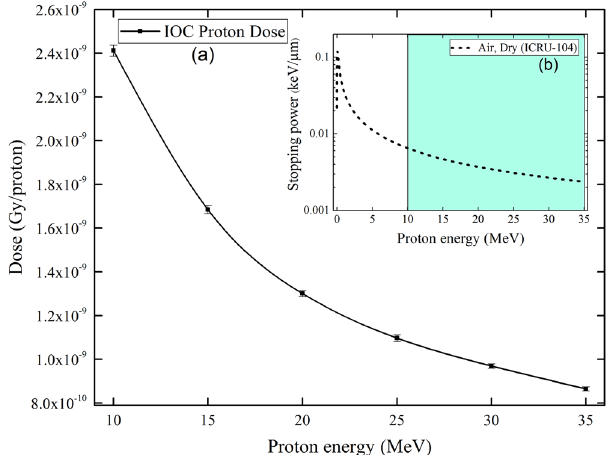
Figure 3. ( a ) Proton dose deposited in the sensitive volume of ionization chamber from protons with different incident energies. ( b ) Stopping power of protons in dry air as a function of incident proton energy (the green region indicates the energy range of incident protons considered in the present